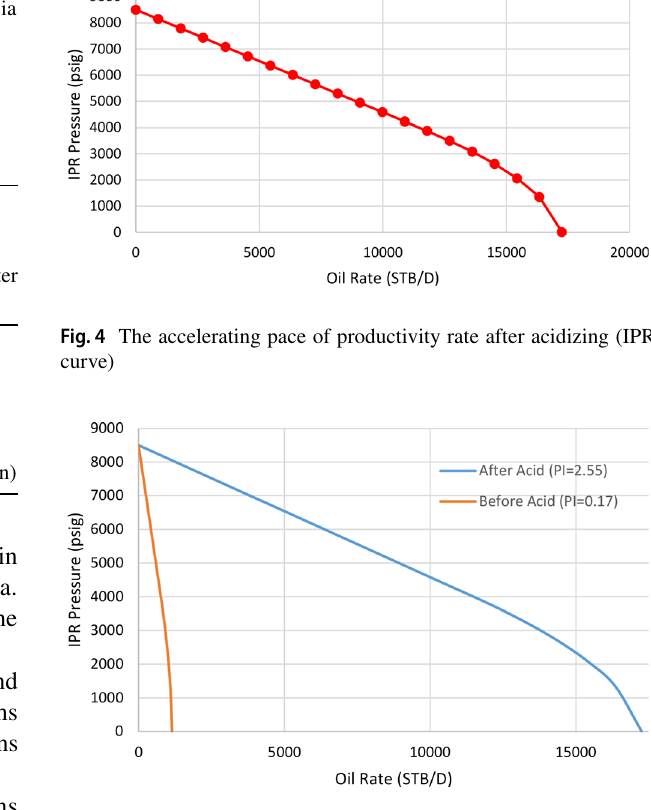
Fig. 5 Comparison of the accelerating pace of productivity rate before and after acidizing (IPR